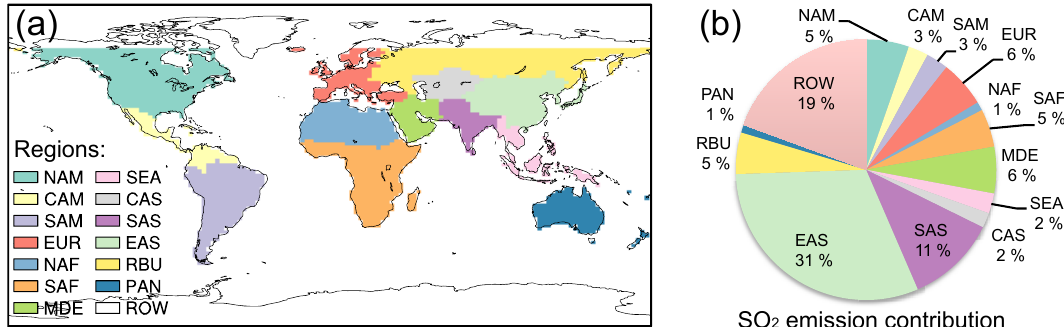
Figure 1. (a) Tagged source regions (NAM: North America; CAM: Central America; SAM: South America; EUR: Europe; NAF: North Africa; SAF: Southern Africa; MDE: the Middle East; SEA: Southeast Asia; CAS: Central Asia; SAS: South Asia; EAS: East Asia; RBU: Russia/Belarus/Ukraine; PAN: Pacific/Australia/New Zealand; and ROW: rest of the world) and (b) the respective percentage contributions to global annual mean combustion SO 2 emissions (anthropogenic + biomass burning) from the individual source regions.